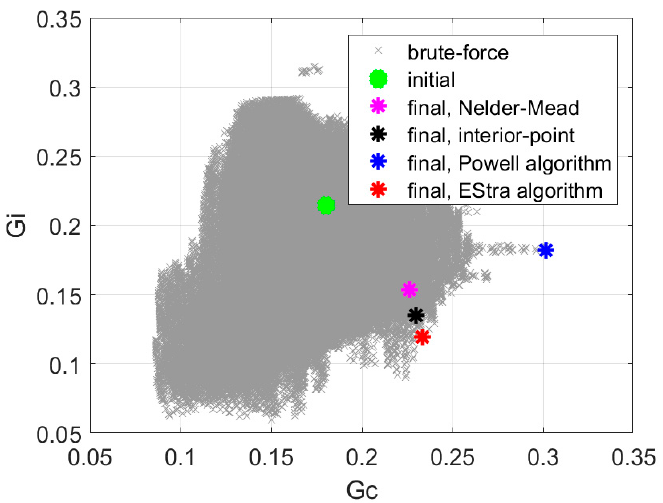
Figure 13. The history of optimization in the space of objective function components for optimization with P-EStra algorithm. Table 1. Comparison of optimization algorithm variants in terms of performance.